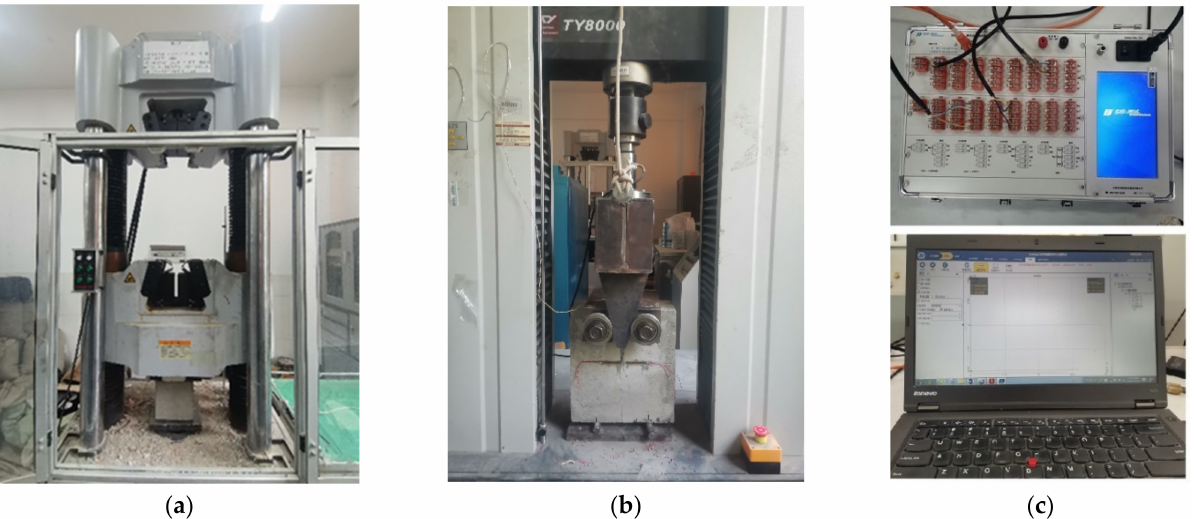
Figure 5. Test equipment: ( a ) Servo Hydraulic Universal Testing Machine; ( b ) computer-controlled electronic universal testing machine; ( c ) data acquisition